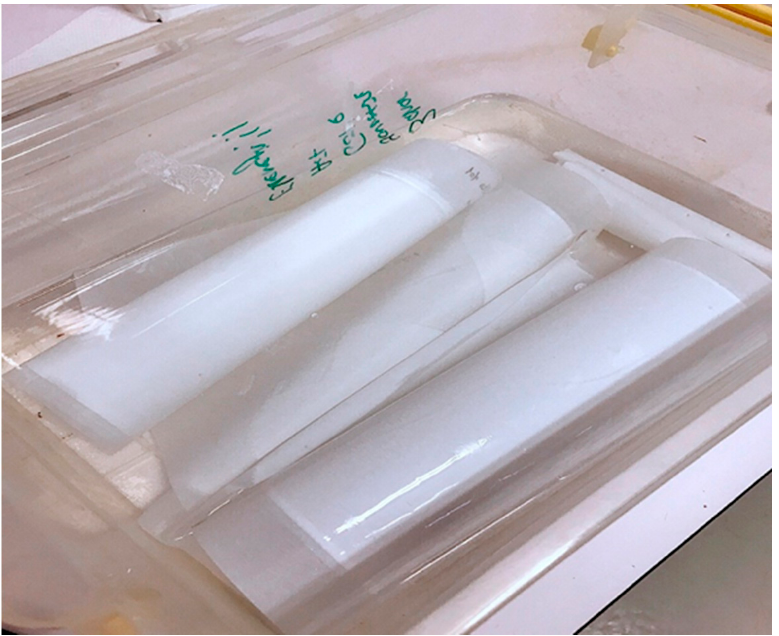
Figure 2. Manufactured membranes.